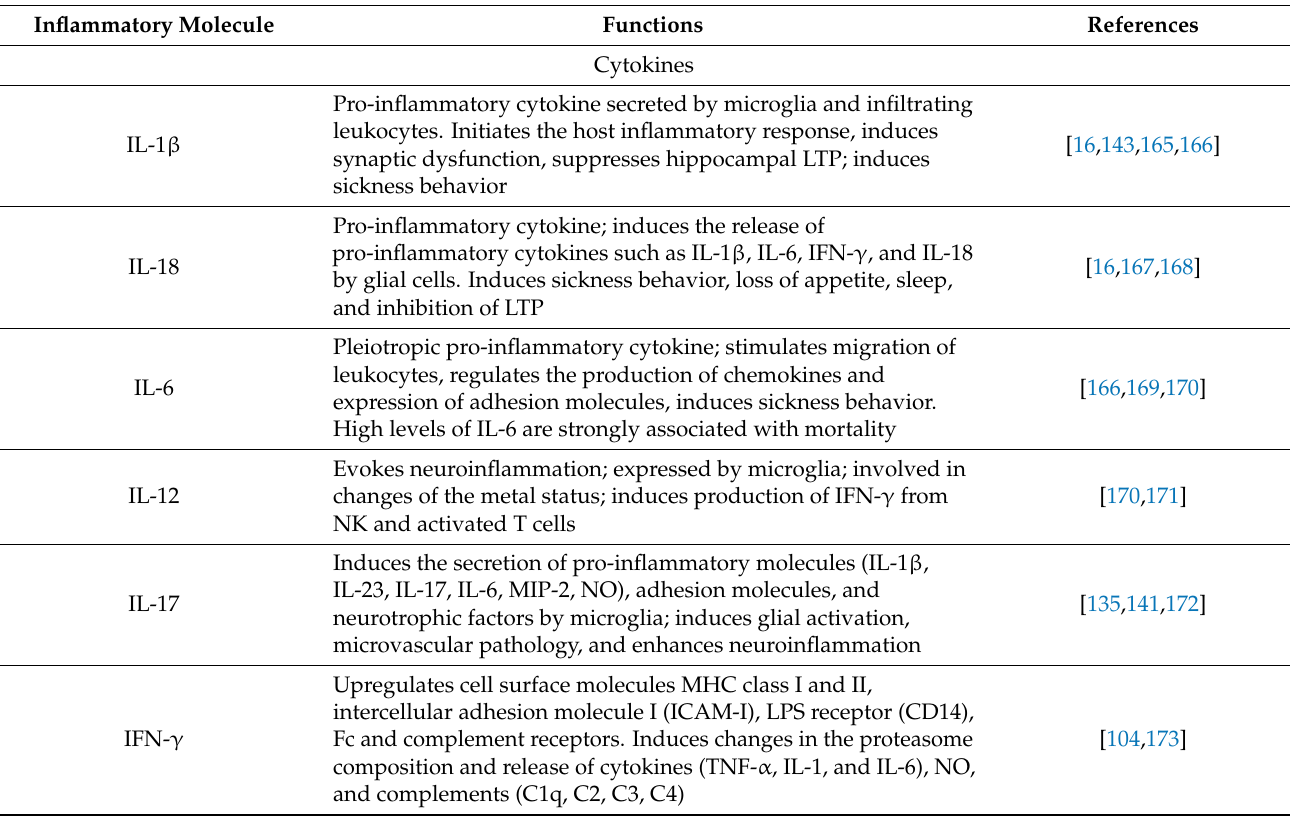
Table 1. Summary of the main inflammatory molecules released by the microglia involved in the pathophysiology of sepsis-associated encephalopathy. Inflammatory Molecule